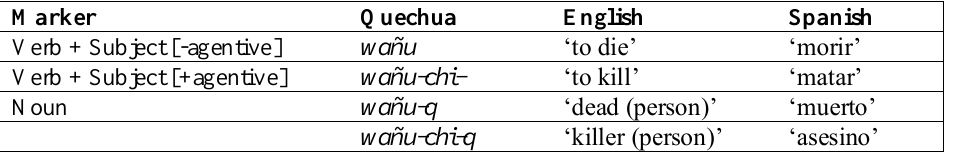
Table 6. Quechua agentive grammatical markers